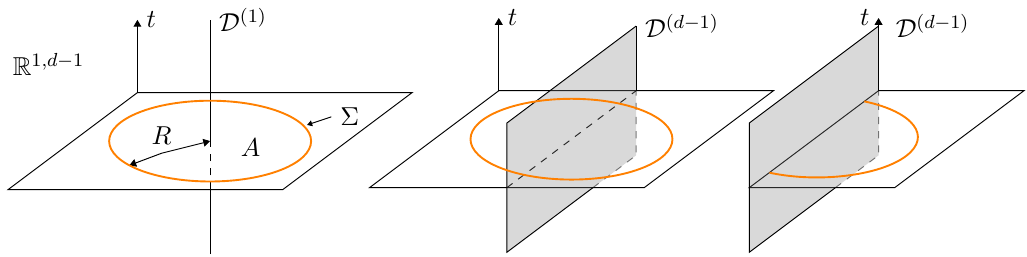
Figure 1 . (Left) A dimension-one conformal defect D (1) in Lorentzian (cid:13)at spacetime. The spherical subsystem A of radius R surrounds the defect. (Center, Right) A codimension-one defects D ( d (cid:0) 1) as an interface (Center) and a boundary (Right). The subsystem A intersects with the defect in these